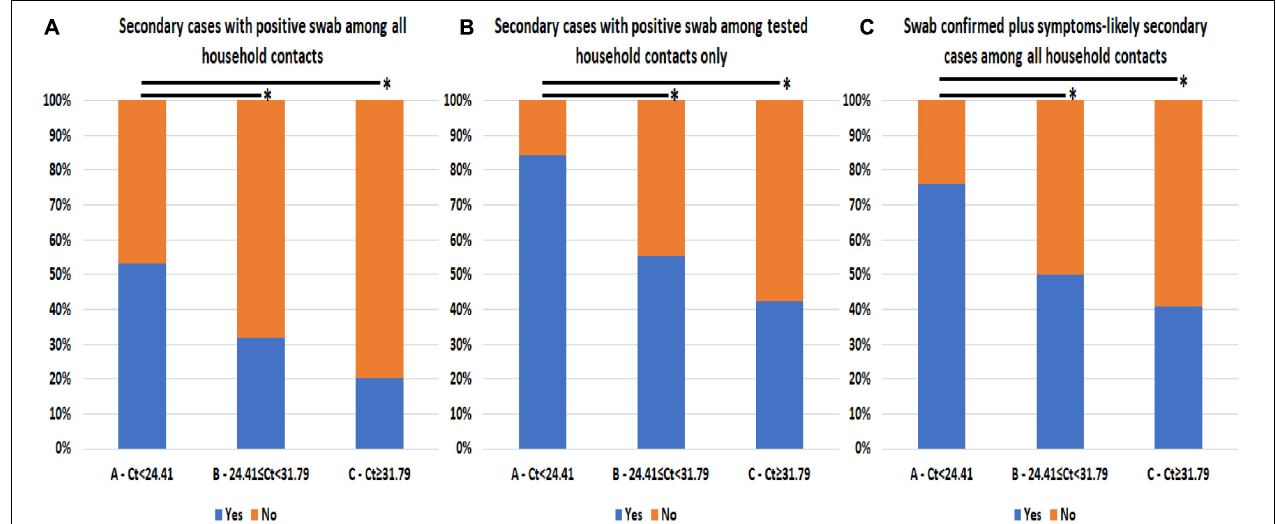
FIGURE 1 | Prevalence of secondary SARS-CoV-2 infections among household contacts according to cycle threshold (Ct) values from the diagnostic nasal–pharyngeal swab of linked index cases. (A) Swab-confirmed secondary cases among all the household contacts stratified according to index first Ct value. (B) Swab-confirmed secondary cases among only the household contacts that underwent testing stratified according to index first Ct value. (C) Swab-confirmed secondary cases plus symptoms-based likely positive secondary cases among all the household contacts stratified according to index first Ct value. ∗ Comparison with p -value < 0.05 is